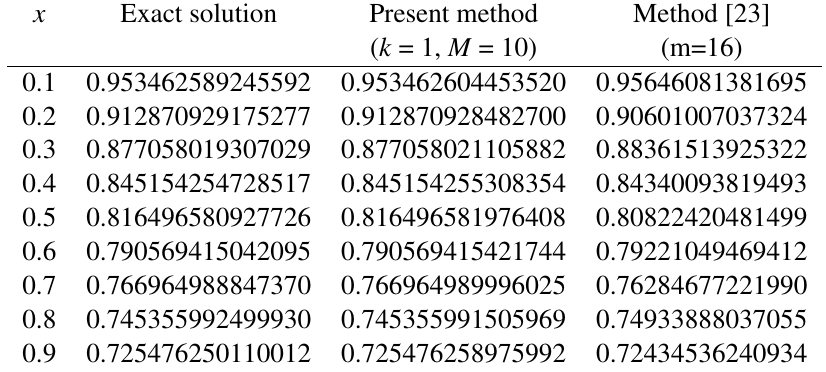
Table 4 Numerical results of example 3.